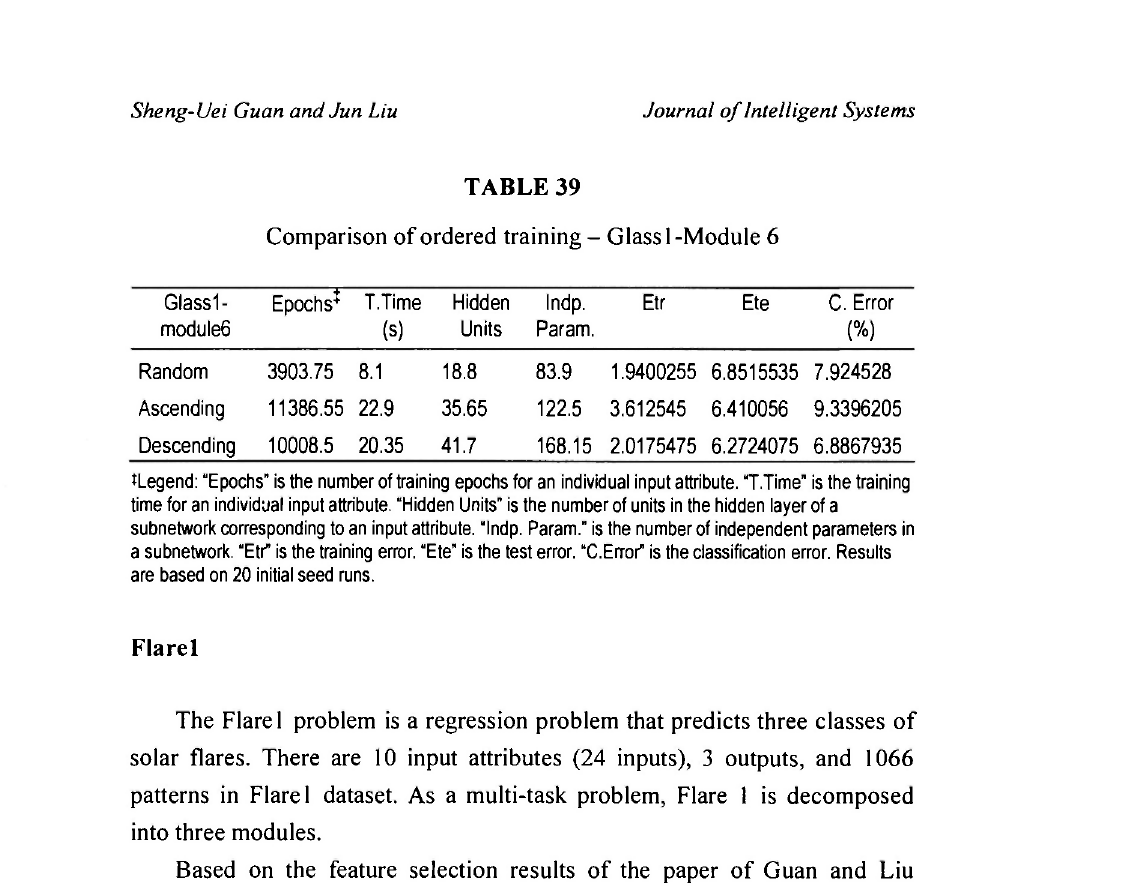
Attribute ranking - Flarel-Module